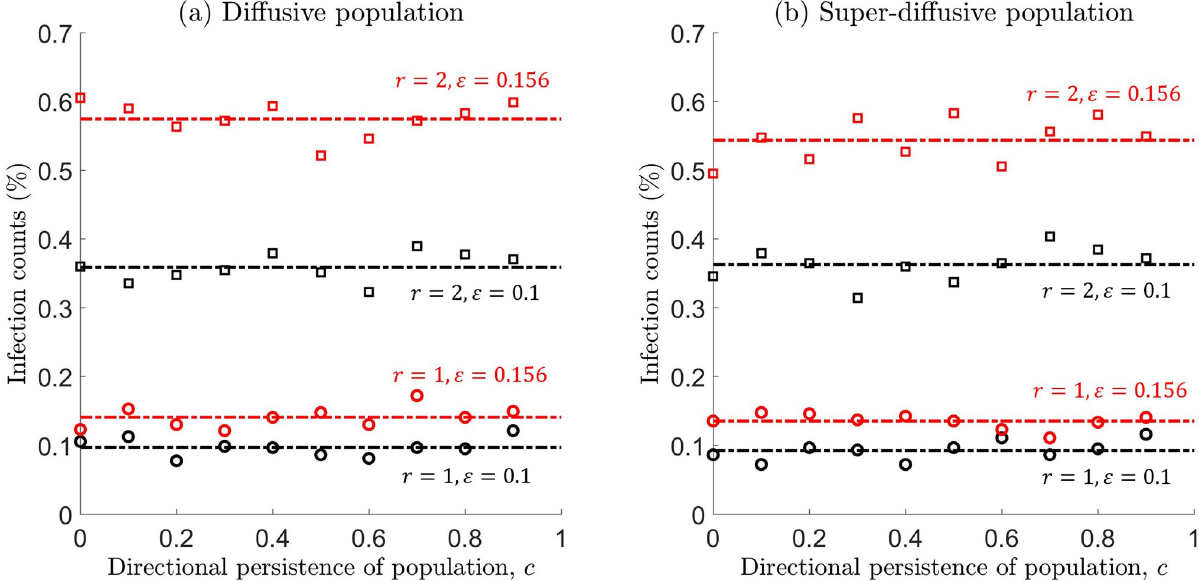
Fig 7. Cumulative infection counts (%) as a function of the mean cosine c , whilst considering different modes of population dispersal: (a) diffusive (CRW with σ = 0.1) or (b) super-diffusive (CLW with γ = 0.1536). These mobility parameters are related through Eq (18), so that infection counts can be compared across different population movement types. Infection counts are recorded at time t = 3 days ( n = 2880 steps in the walk), and computed for different interaction radii r = 1, 2m and different transmission probabilities � = 0.1, 0.156. All other simulation parameters are the same as that in the caption of Fig 3. Simulations were averaged over ten runs, to reduce the effect of stochastic